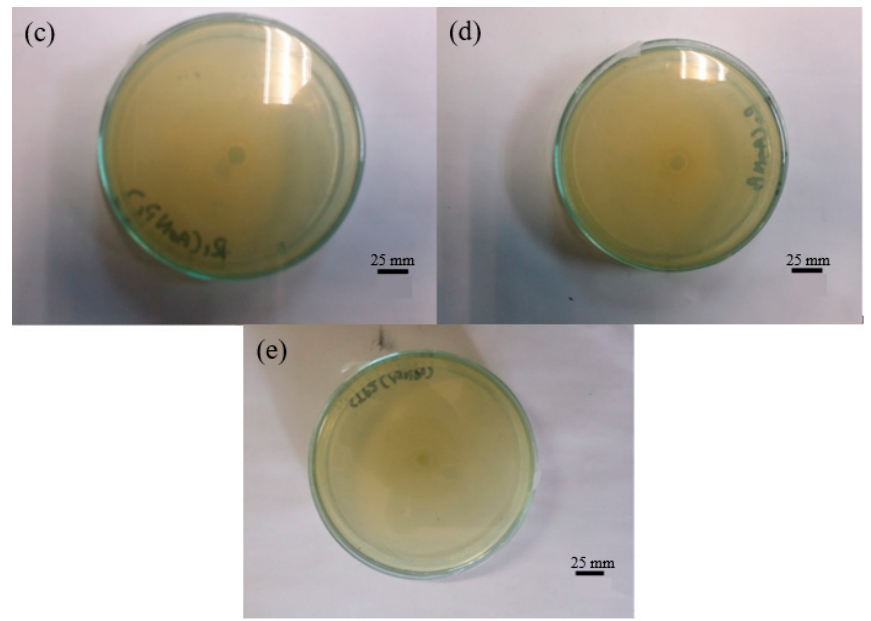
Figure 8. Zone of inhibition of AgNPs synthesized using Euphorbia hirta against ( a ) E. coli ; ( b ) B. cereus ; ( c ) C. haemolyticum UDIN2; ( d ) C. haemolyticum UDIN3; and ( e ) C. haemolyticum UDIN1. Table 4. Zone of inhibition of AgNPs, AgNO 3 , water and plant extracts.